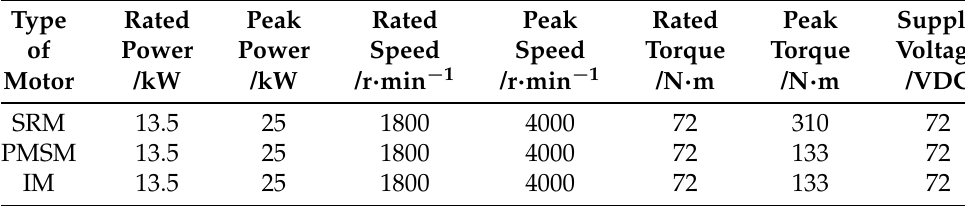
Table 3. Three hydraulic motor parameters.